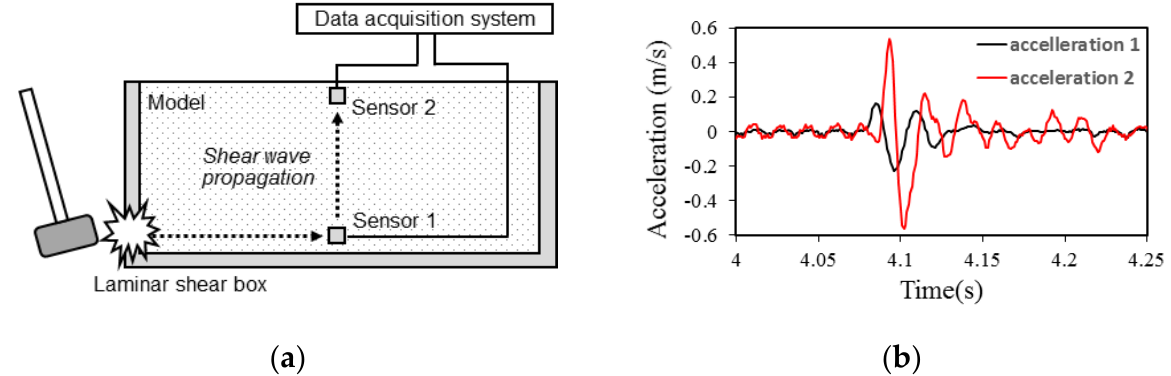
Figure 6. The shear wave velocity measurement method used in this study: ( a ) shear wave generation by physical impact; ( b ) output signals of two accelerometers.